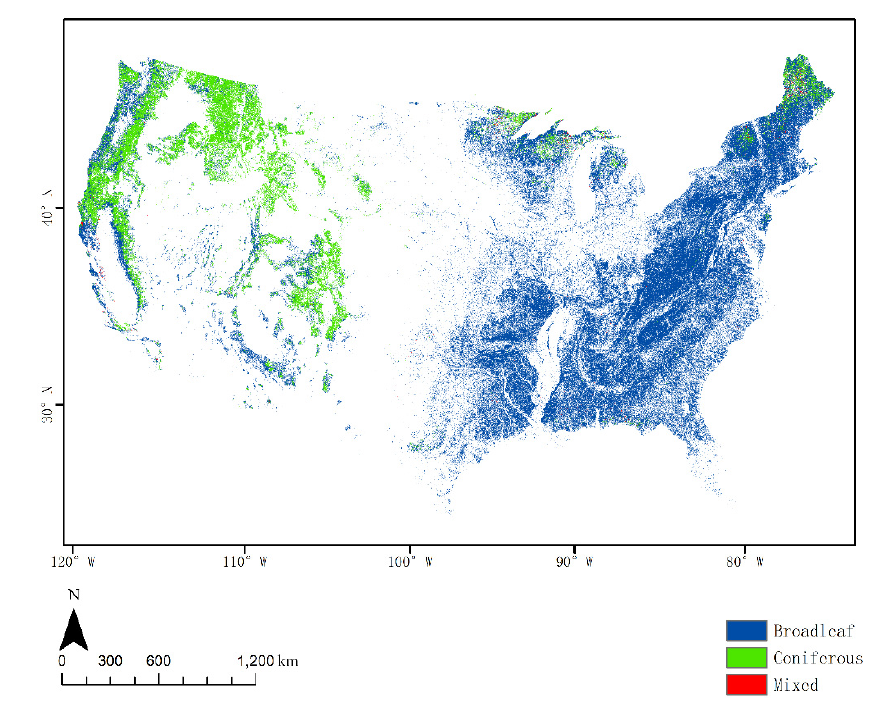
Figure 10. Integration Model I: second-level class refinement results of GlobeLand30 forest.